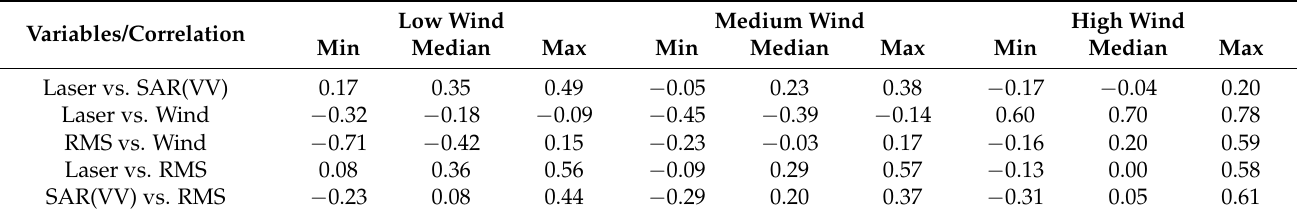
Figure 10. Correlation factor (colour bar) between PLS intensity and SAR backscatter evaluated for different overlapping sectors ranging in 90° wind directions. In the figure, each sector represents a 90° wind-direction section and each of the 12 rings represent a row of pixels starting from pixel 1, which is located on the sea-side (inner ring), and moving towards pixel 12 (external ring), which is located on the city-side of the study area. The dotted black line represents the orientation of the shore line in Noordwijk. Table 2. Linear correlation coefficients (maximum, minimum and median values within the consid- ered 12 pixels) between the indicated variables for the three considered wind-speed conditions: low (<4 m/s), medium (4.1m/s–8m/s) and high (>8m/s) wind